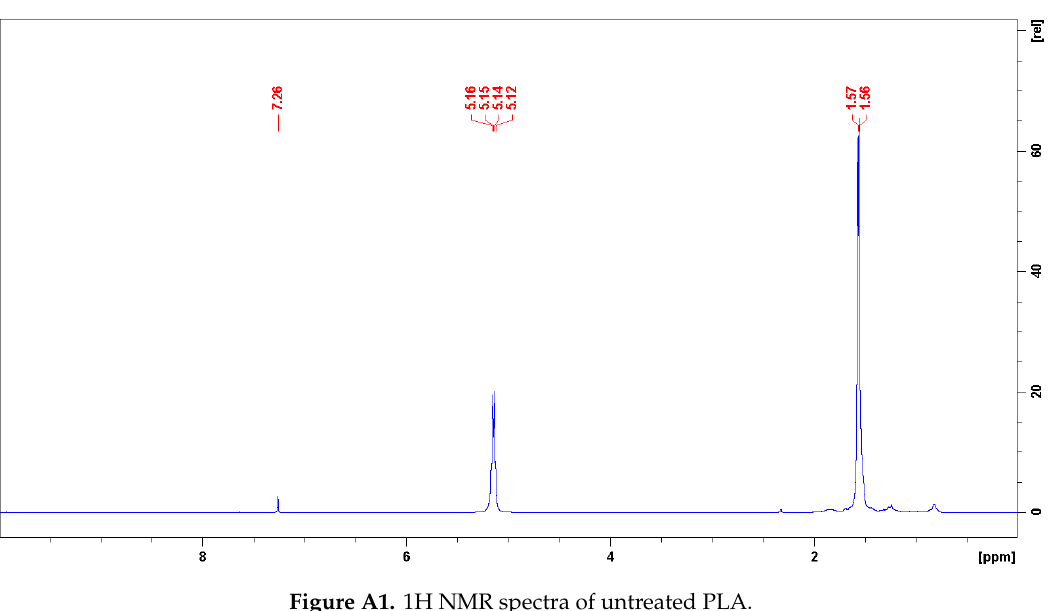
Figure A1. 1H NMR spectra of untreated PLA.